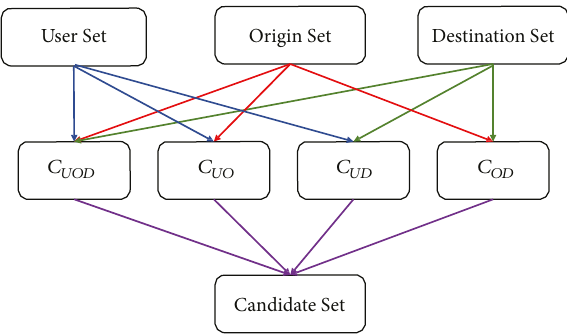
Figure 4: The candidate generation